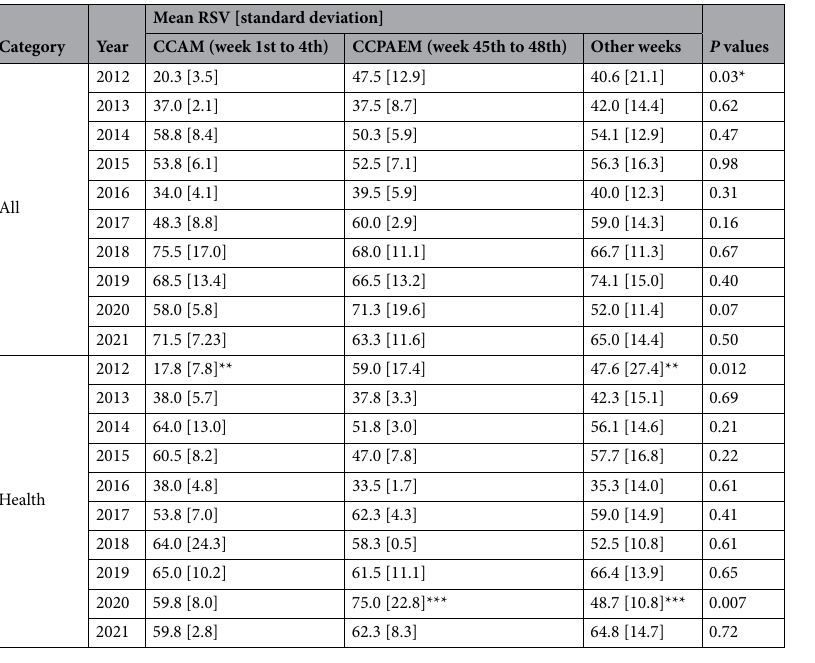
Table 4. Comparison of mean relative search volumes (RSV) of “Shikyuu-keigan (cervical cancer)”, 2012– 2021. *A significant difference was not observed among any mean RSVs after bonferroni adjustment. **Mean RSV in CCAM was significantly lower than that in other weeks ( p = 0.028). ***Mean RSV in CCPAEM was significantly higher than that in other weeks ( p = 0.044). P values were calculated by Kruskal–Wallis